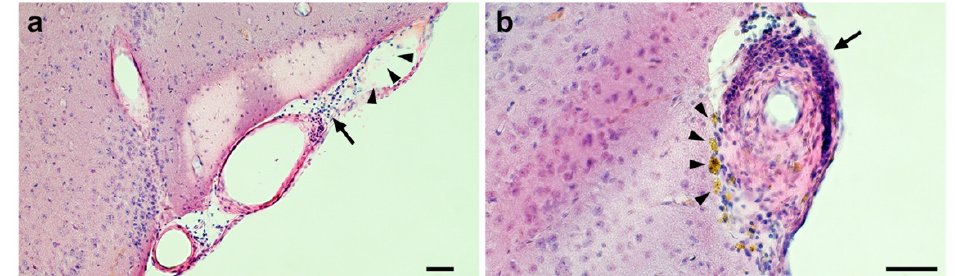
Figure A2. A representative image of accumulation of erythrocytes or hemosiderin. Accumulation of erythrocytes or hemosiderin shown in a Tg2576 mouse (aged 21 months old) fed with aspirin (i.e., aspirin group) (H&E stain). ( a ) Small accumulations of erythrocytes (arrow heads) are found around a leptomeningeal artery with lymphocytic infiltration (arrow). ( b ) Hemosiderin depositions (arrow heads) are seen around a leptomeningeal artery with vasculitis (arrow). Scale bars indicate 50 μm.